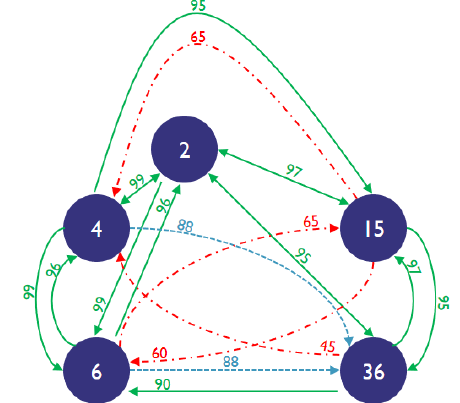
Figure 14. Network topology and PDR representation of real lab setup.